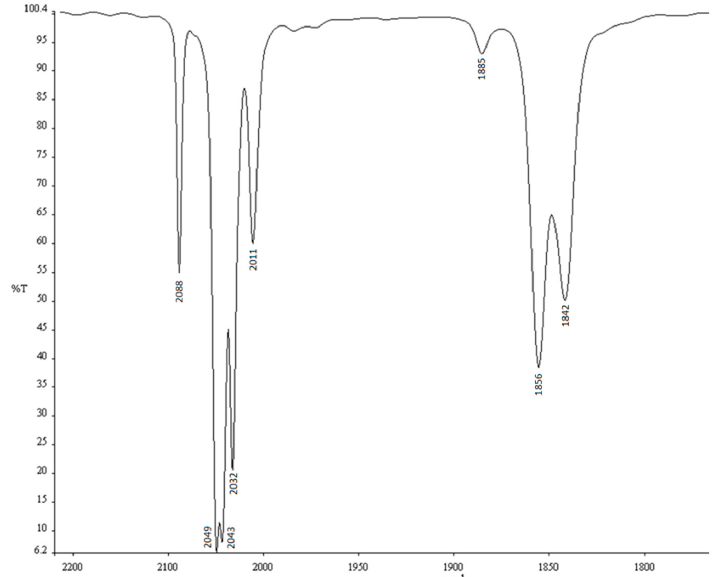
Figure 1. IR spectrum of compound 2 recorded in cyclohexane.